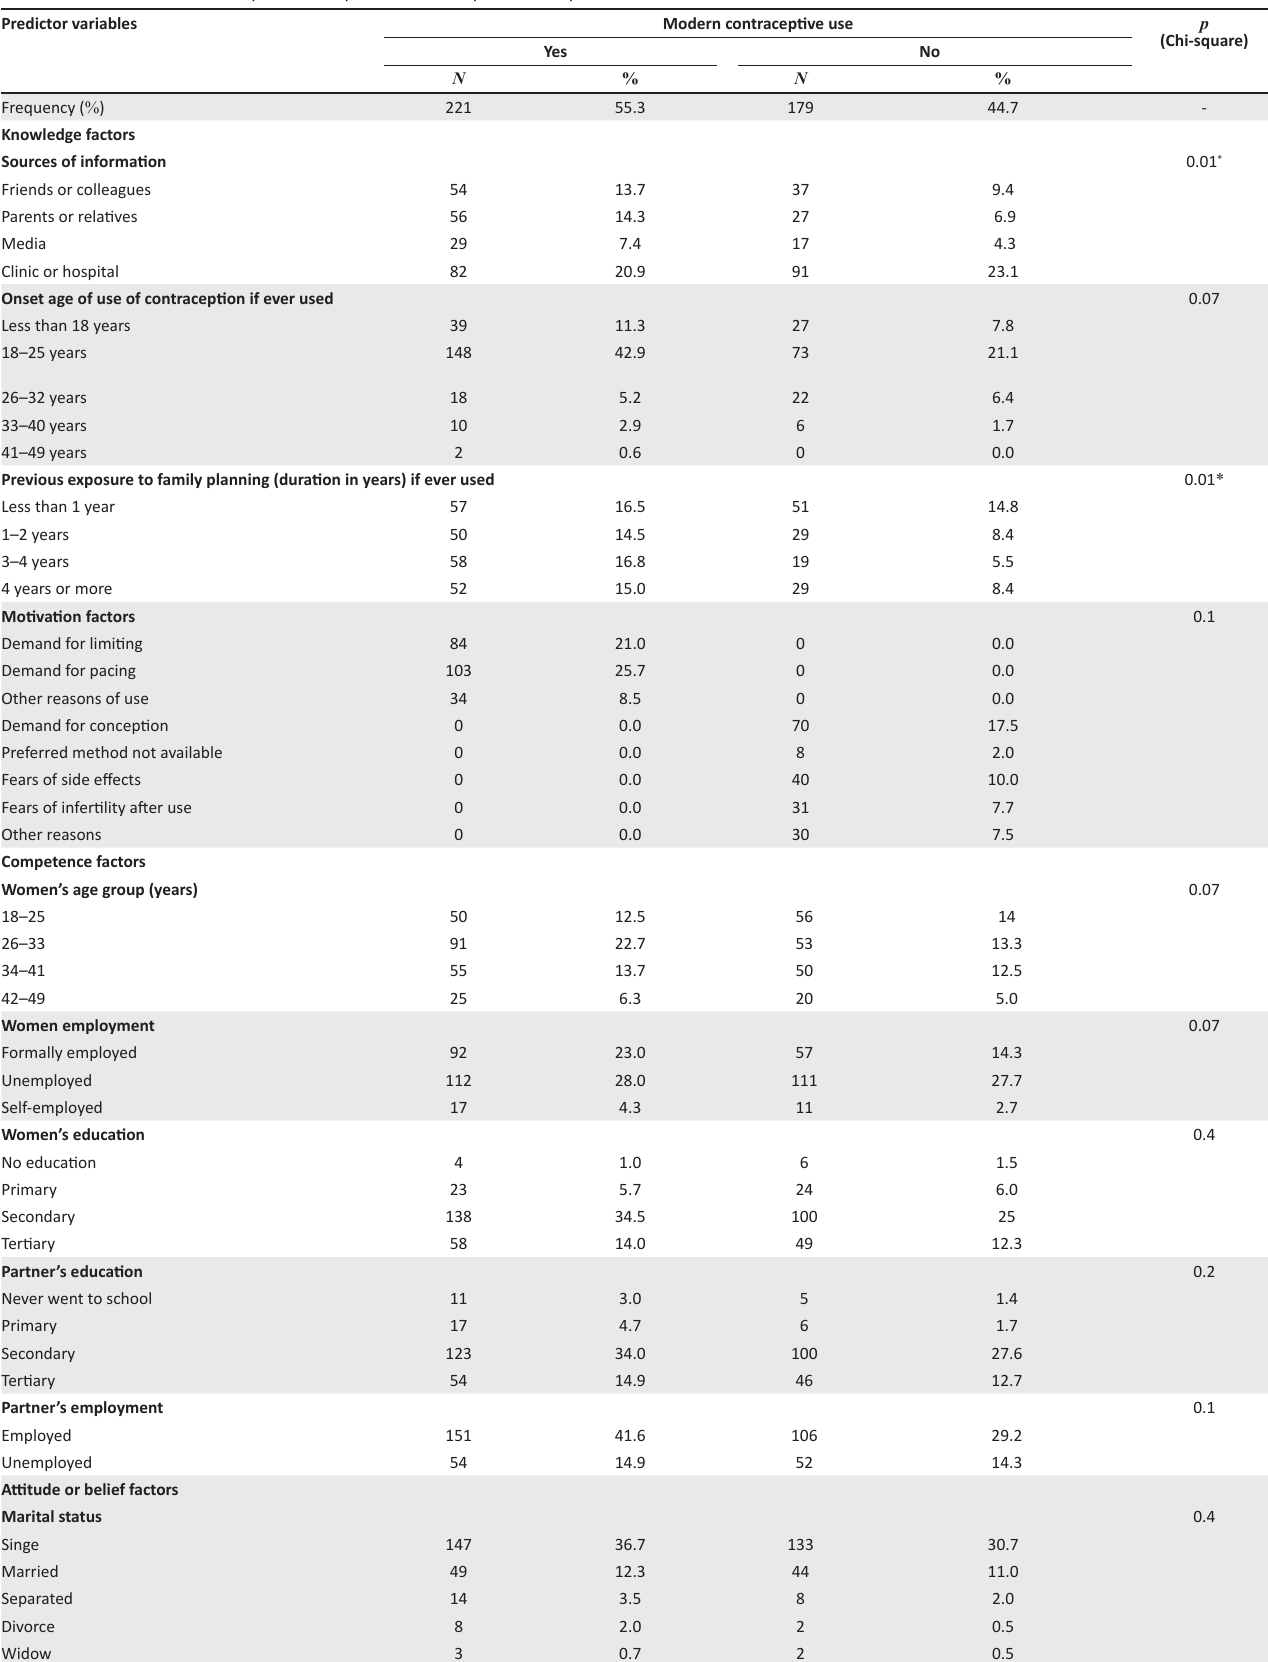
TABLE 2: Distribution of contraceptive use as per the four components of operational framework. Predictor